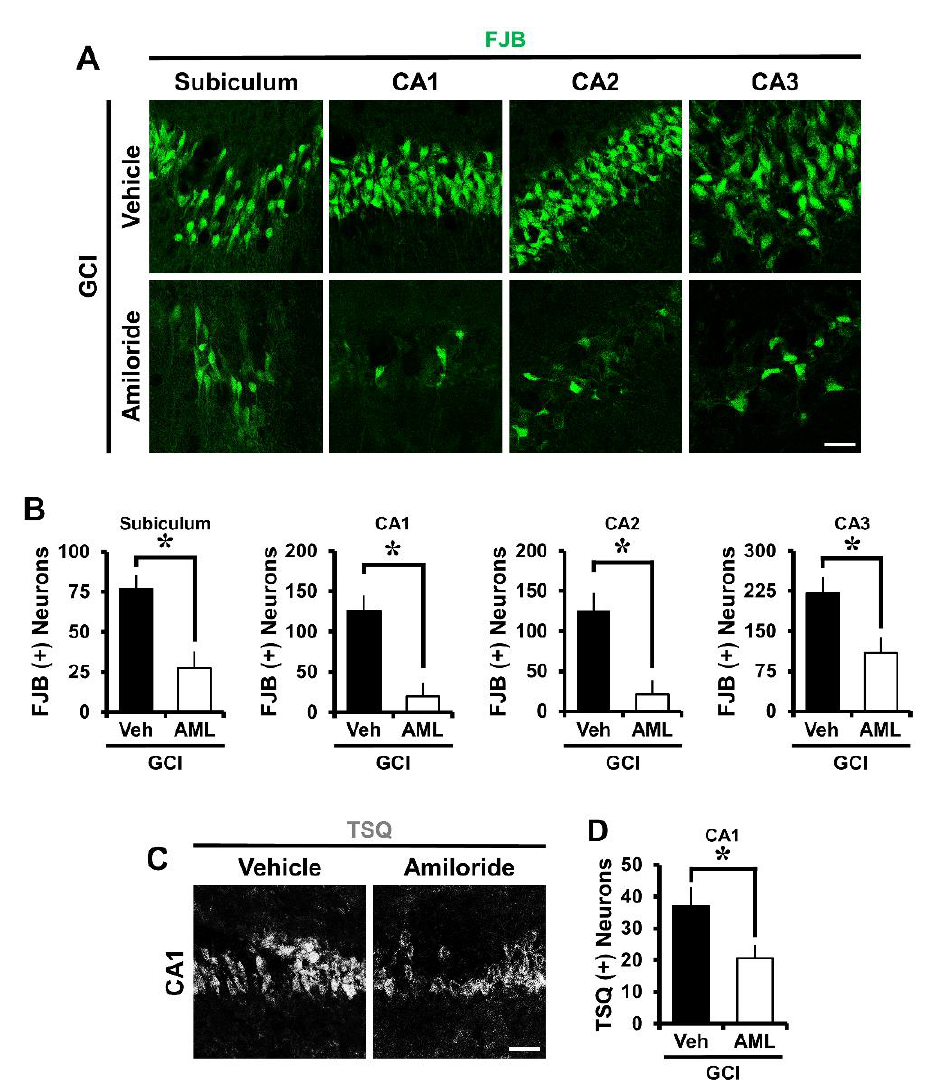
Figure 1. Amiloride treatment decreased the number of degenerating neurons and zinc accumulation after global cerebral ischemia (GCI). GCI-induced hippocampus neuronal death was confirmed in the subiculum (Sub), cornus ammonis 1 (CA1), CA2, and CA3 regions after ischemic insult. Zinc accumulation was confirmed in the CA1 region after ischemic insult. ( A ) Fluorescent images show degenerated neurons in the Sub, CA1, CA2, and CA3 regions. Intraperitoneal post-treatment with amiloride (10 mg / kg) reduced neuronal death in the Sub, CA1, CA2, and CA3 regions at 24 h after ischemia. Scale bar = 20 µ m. ( B ) Bar graph displaying the quantification of degenerating neurons in the hippocampal regions. The number of FJB ( + ) neurons was decreased in the amiloride-injected (10 mg / kg) group in the Sub, CA1, CA2, and CA3 regions compared with the vehicle-treated group (GCI-vehicle, n = 8; GCI-amiloride, n = 8). ( C ) Representative images show N -(6-methoxy-8-quinolyl)-para-toluenesulfonamide (TSQ) ( + ) neurons in the CA1 region. Scale bar = 20 µ m. ( D ) The bar graph indicates the TSQ ( + ) neurons in the hippocampal CA1 region (GCI-vehicle, n = 8; GCI-amiloride, n = 10). Data are mean ± S.E.M. * Considerably di ff erent from the vehicle-treated group, p < 0.05. (Mann–Whitney U test (B) Sub: z = 2.626, p = 0.007; CA1: z = 2.838, p = 0.003; CA2: z = 2.836, p = 0.003; CA3: z = 2.205, p = 0.028; (D) CA1: z = 2.134, p = 0.034).